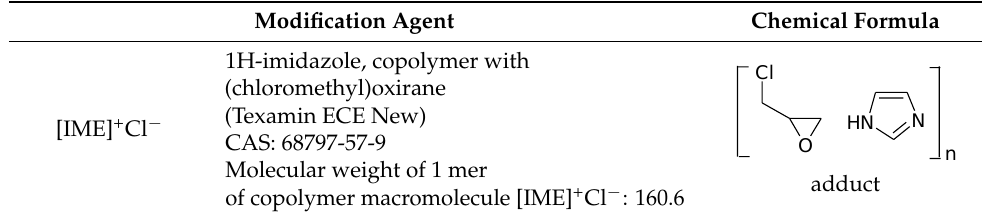
Table 1. Information data of the modification agent.